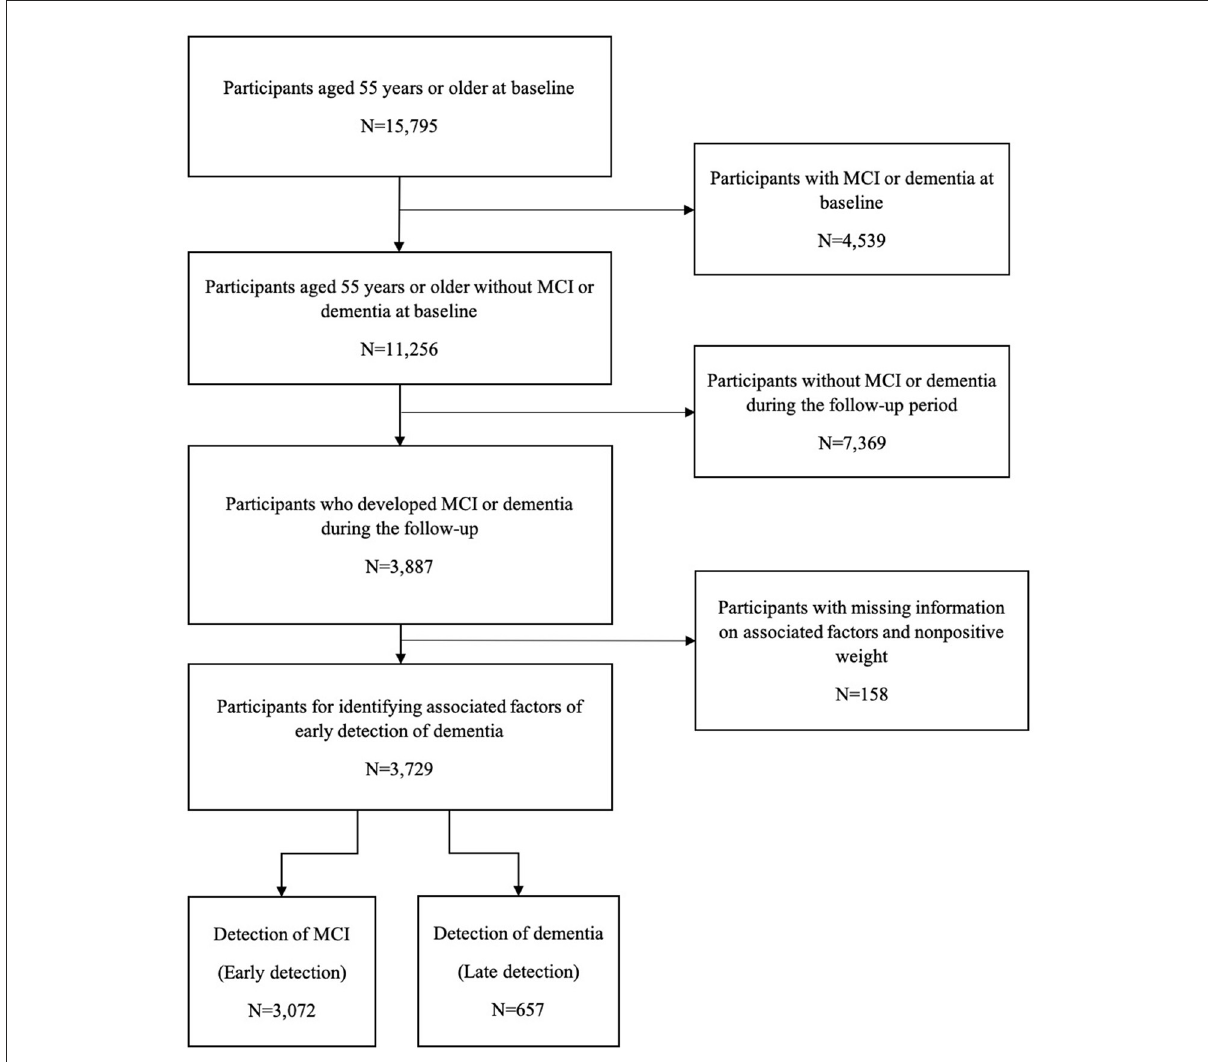
FIGURE1 Flowchart of study sample selection. MCI, mild cognitive